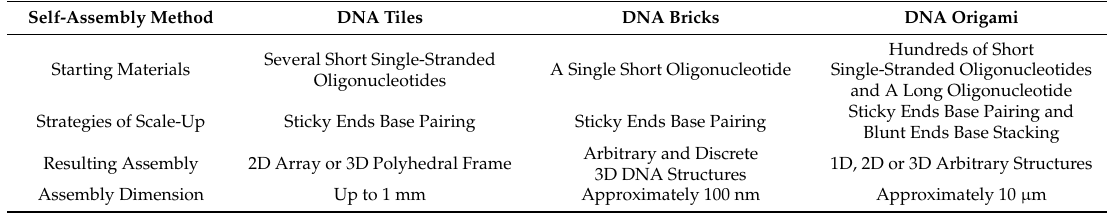
Table 1. Characteristics of the three self-assembly